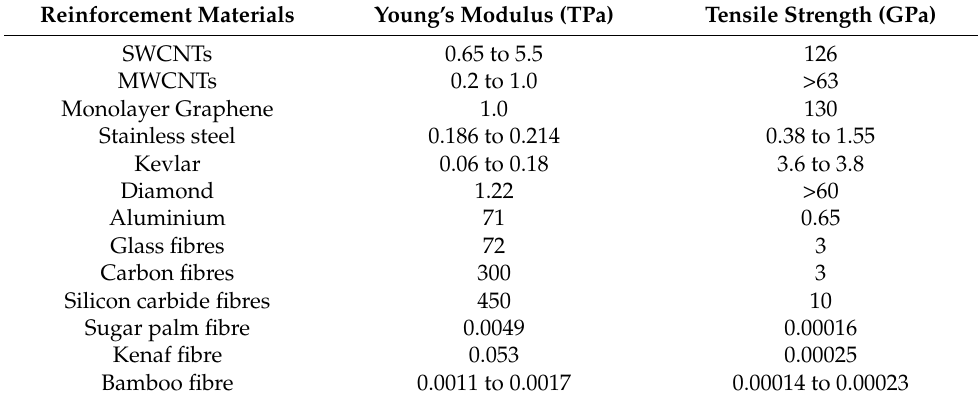
Table 2. Mechanical properties of CNTs with other example of reinforcing